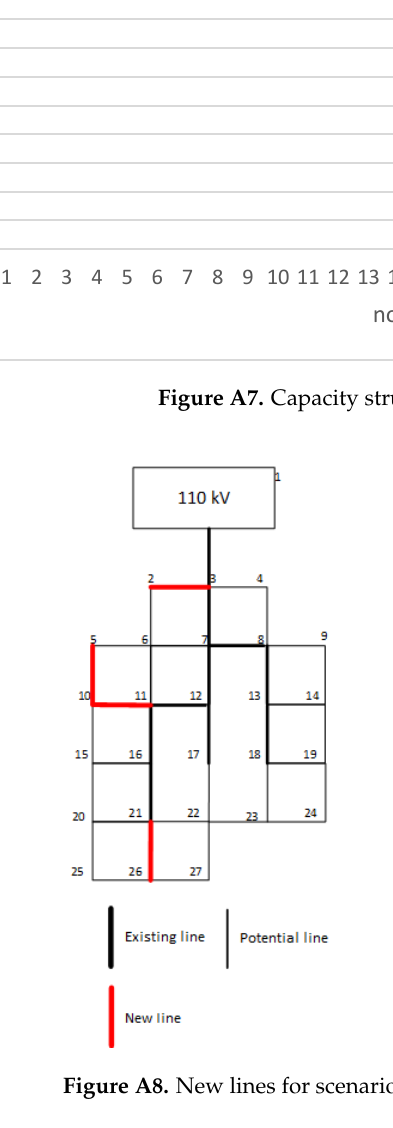
Figure A9. New lines for scenario “5”. Equations corresponding to Equation (9) that describe power losses in lines. ∀ 𝑡 ∈ 𝑇